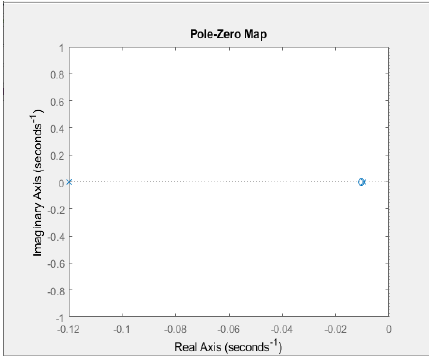
Figure 17. Diagram of poles and zeros of three state variables.